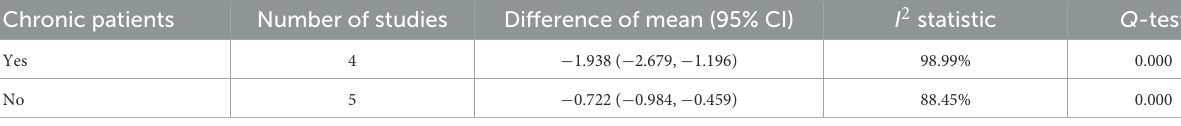
TABLE 4 Effect of the chronic condition of the participants on affective symptomatology. Chronic patients